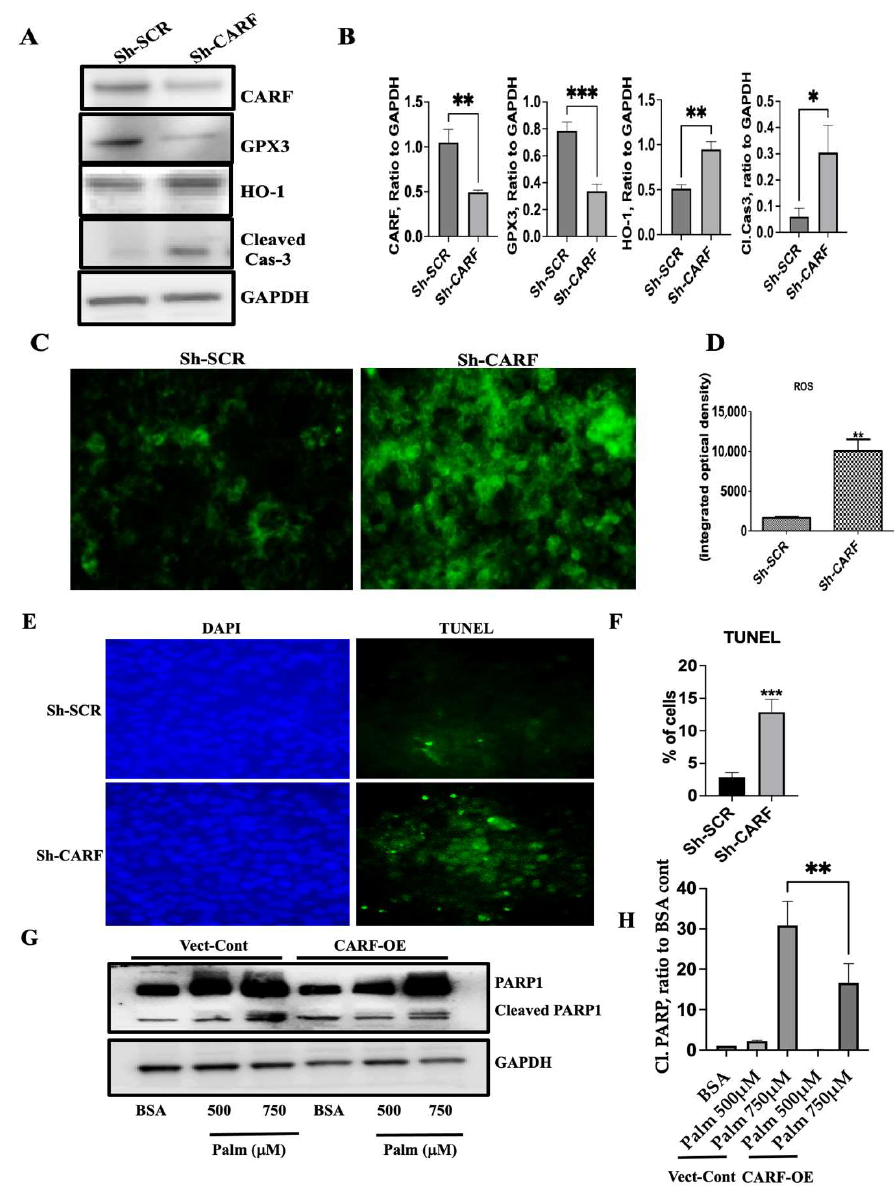
Figure 6. Silencing of CARF induces oxidative stress and apoptosis in HepG2 cells. Western blot analysis of indicated genes shows the effect of CARF knockdown on oxidative stress in HepG2 cells. GAPDH was used as the loading control ( A ). Quantification of Western blotting bands from 3 independent experiments (* p < 0.05, ** p < 0.01. *** p < 0.001) ( B ). HepG2 cells were stained with non-fluorescent H2DCFDA 72 h after knockdown of CARF to show the level of ROS ( C ). The average integrated optical density of the H2DCFDA-stained images ( n ≥ 5) using Image-Pro software (** p < 0.01), ( D ). TUNEL staining after CARF knockdown in HepG2 cells. Upper panels represent Sh-SCR-treated cells and lower panels represent Sh-CARF-treated cells ( E ). Graph showing that ~ 12.8% cells are TUNEL positive for Sh-CARF-treated cells compared to 2.8% in Sh-SCR-treated cells. DAPI positive and TUNEL positive cells from six different microscope fields were counted and percentage of TUNEL positive cells are shown. (*** p < 0.001) ( F ). Western blot analysis of PARP1 gene to show CARF overexpression reduces the palmitate-induced apoptosis ( G ) Quantification of cleaved PARP1 from 3 independent experiments. ( H ). Parametric, unpaired Student’s t -test and one-way ANOVA with Holm–Sidak’s multiple comparison method were used to compare between two groups and multiple groups, respectively. (** p < 0.01). Table 1. ROS signaling associated genes.